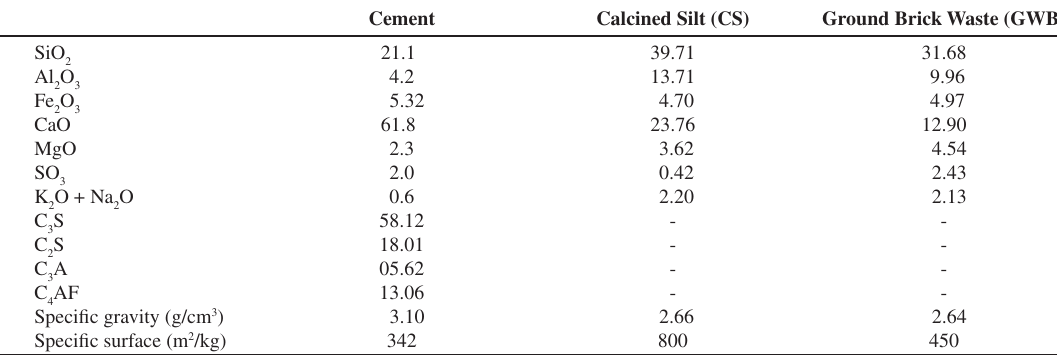
Table 1. Characteristics of cementitious materials.